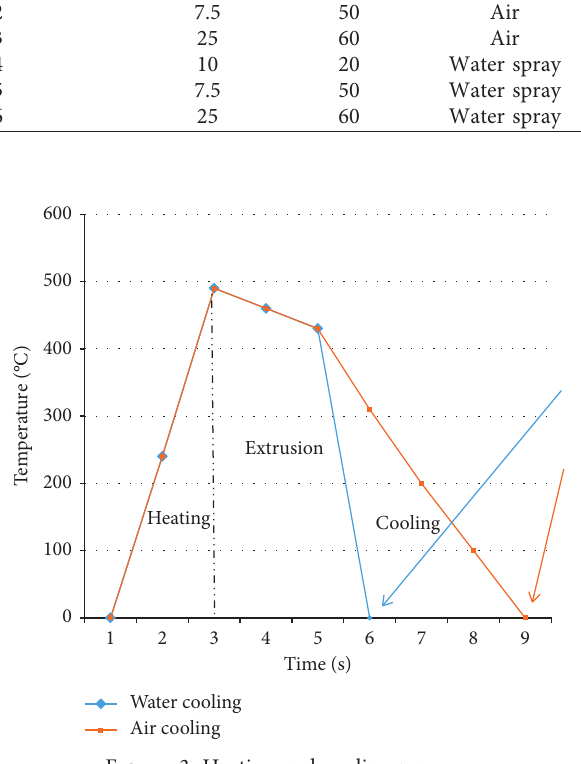
Figure 3: Heating and cooling